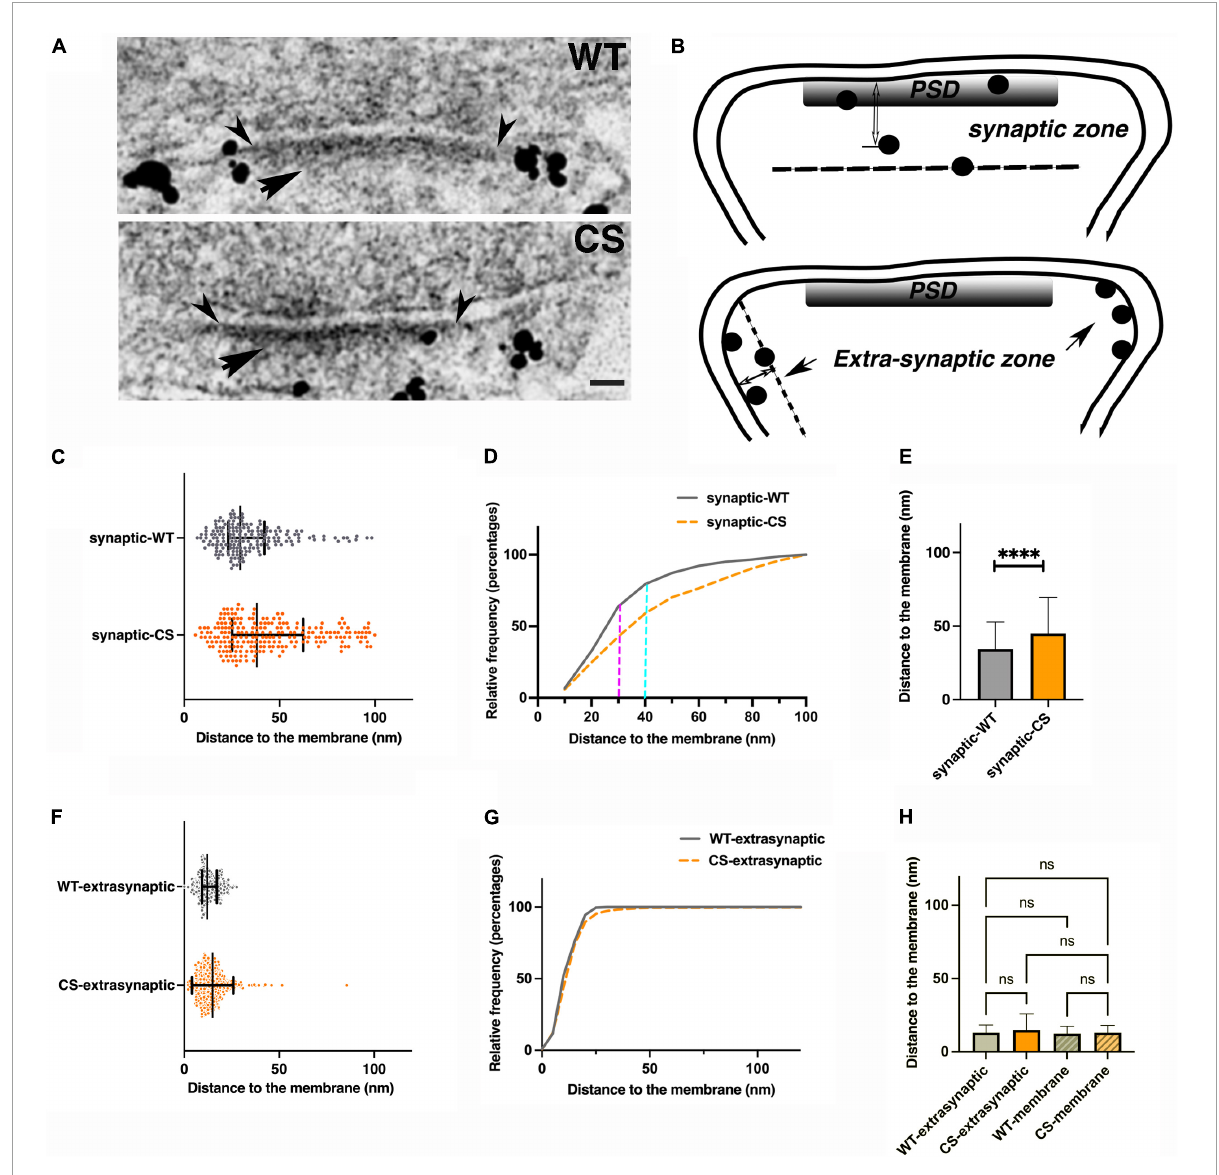
FIGURE2 Palmitoylation effects on nano-scale localization of endogenous AKAP150 in hippocampal mouse spine synapses by immunogold EM. (A) Electron micrographs of individual synapses labeled for AKAP150 (WT and CS). Arrowheads point to outer edge of the electron dense PSD at the postsynaptic membrane. Arrow points to the PSD. Scale bar 100 nm. (B) Schematic drawings of synaptic vs. extra-synaptic zones designated for measuring AKAP150 immunogold particle distances to postsynaptic membrane (PSM). (C,F) Immunogold to membrane distance distribution for WT (blue dots) vs. CS (magenta) with mean and SD in the synaptic zone (C) and extra synaptic zone (F) . (D) Cumulative distribution of data in (C) showing more spread immunogold distribution for CS than WT (WT: N = 180, mean ± SD = 34 ± 18 nm; median = 29 nm, 25% percentile = 23 nm, 75% percentile = 42 nm; CS: N = 222, mean ± SD = 45 ± 25 nm; median = 38 nm, 25% percentile = 25 nm, 75% percentile = 62 nm), and significant percentages of labels are within the core PSD structures up to 30–40 nm from PSM: up to 30 nm to PSM (magenta dash line): ∼ 35% (CS), ∼ 60% (WT); up to 40 nm to PSM (cyan dash line): ∼ 50% (CS), ∼ 70% (WT). (E) Histogram comparing mean gold particle distance to PSM for WT and CS ( P < 0.0001. Mann-Whitney test). (G) Cumulative distribution of data in (F) showing essentially identical immunogold distribution for WT and CS at the extra-synaptic membrane. (H) Histogram comparing immunogold particle to membrane distances at extra-synaptic membrane vs. non-synaptic dendritic membrane show no significant differences. 13 ± 5 nm (WT, extrasynaptic membrane, CV = 0.38, N = 309), 12 ± 5 nm (WT, non-synaptic membrane, CV = 0.42, N = 229, 7 STEM tomograms); 15 ± 11 nm (CS, extra-synaptic membrane, CV = 0.73, N = 403), 13 ± 5 nm (non-synaptic membrane, CS, CV = 0.38, N = 164, 10 STEM tomograms). Ordinary one way ANOVA, Tukey test, WT-extra-synaptic ( N = 309) and CS-extra-synaptic ( N = 403), P = 0.9995; WT-extra-synaptic and WT-membrane ( N = 229) P > 0.9999;WT-extrasynaptic and CS-membrane ( N = 164), P > 0.9999; CS-extrasynaptic and CS-membrane, P = 0.9999; WT-membrane and CS-membrane, P = 0.9978). **** p < 0.0001, ns p >